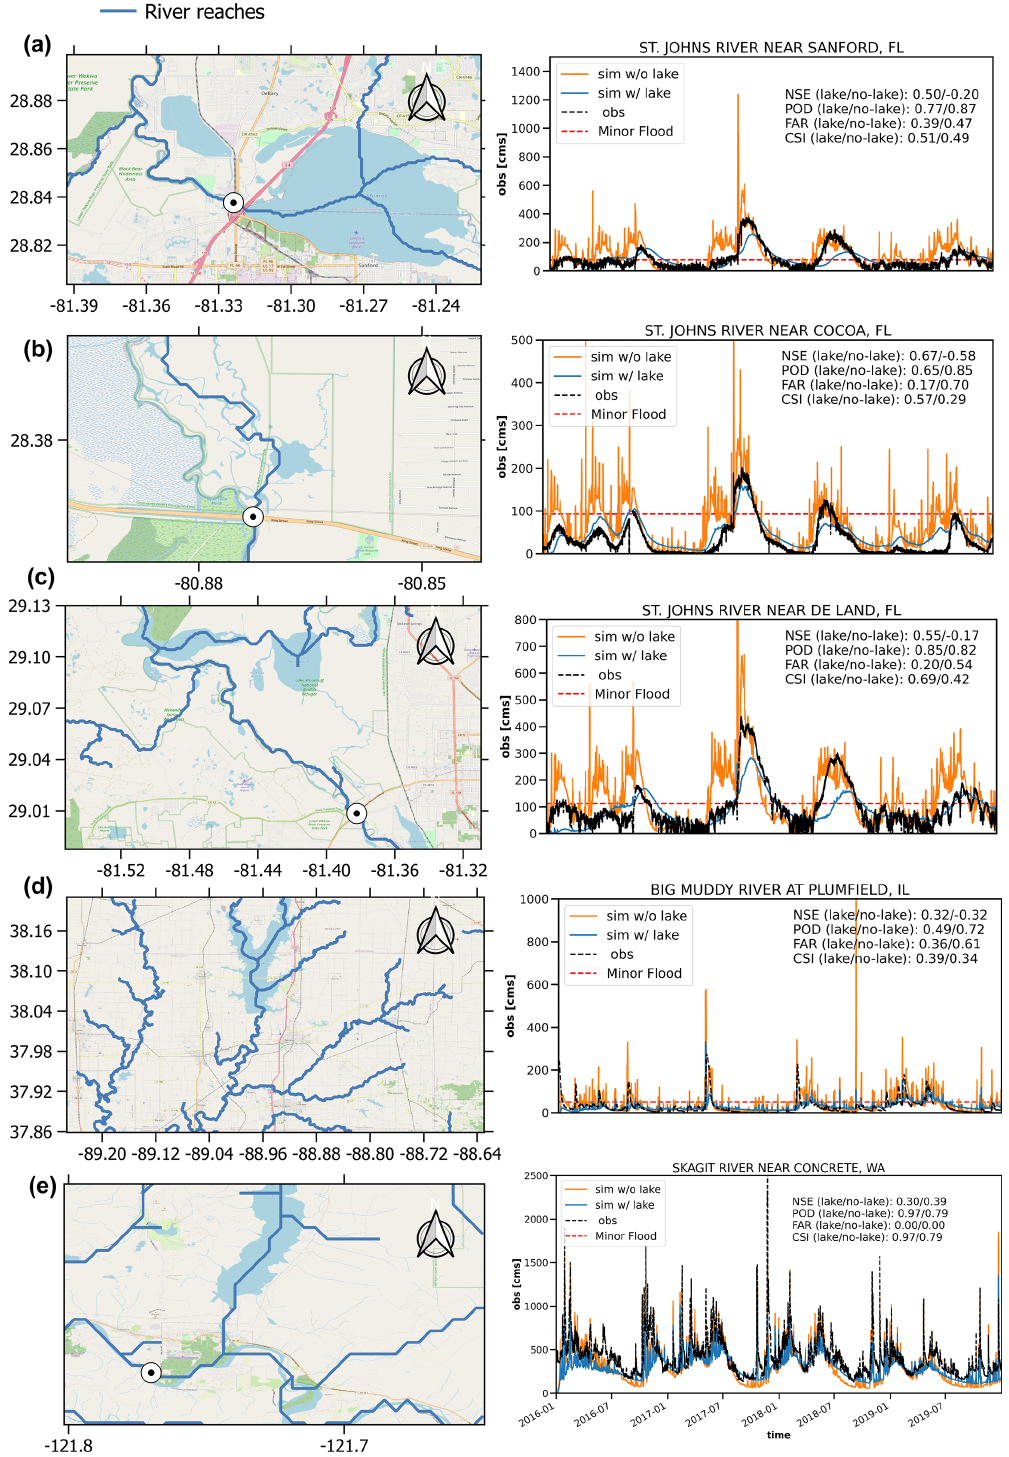
Figure 9. Five case examples of streamflow time series at gauges downstream of lakes: (a) St. Johns River near Sanford, FL; (b) St. Johns River near Cocoa, FL; (c) St. Johns River near De Land, FL; (d) Big Muddy River at Plumfield, IL; (e) Mississippi River at Clinton, IA. Base map copyright © Google